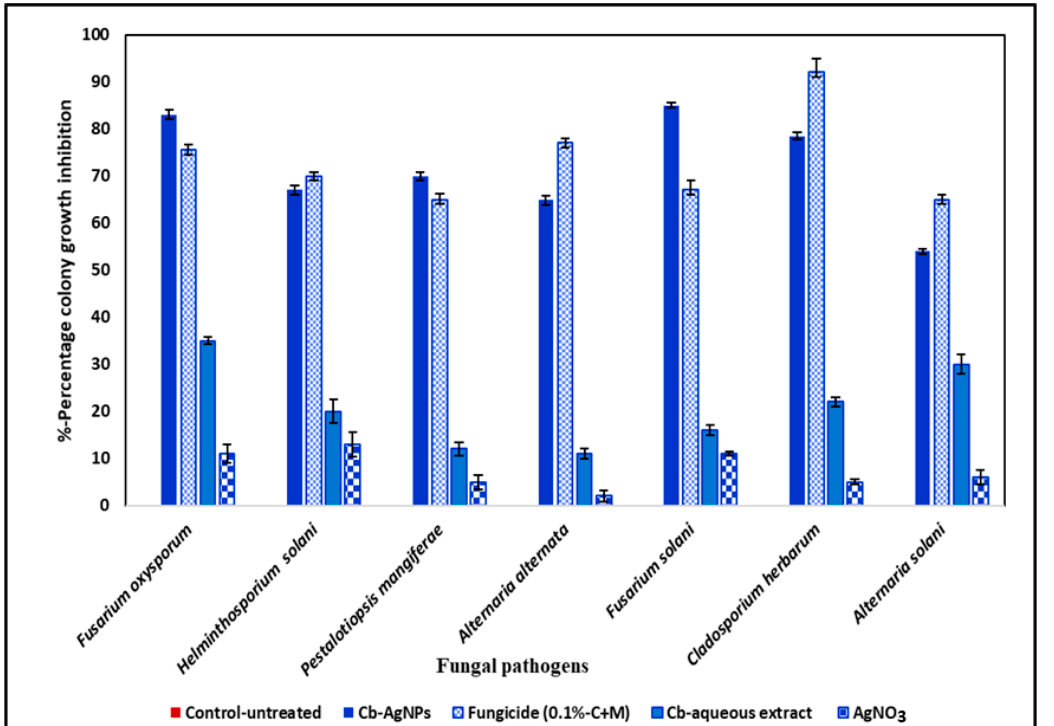
Figure 6. The effect of cranberry extract and synthesized silver nanoparticles (64 µg/mL) on the percentage mycelial growth inhibition of fungal test isolates. The values shown in the graph are an average of three experimental replicates (±SD). Significant differences in means ( p ≤ 0.05) were determined by analysis of variance (ANOVA) and Turkey HSD.